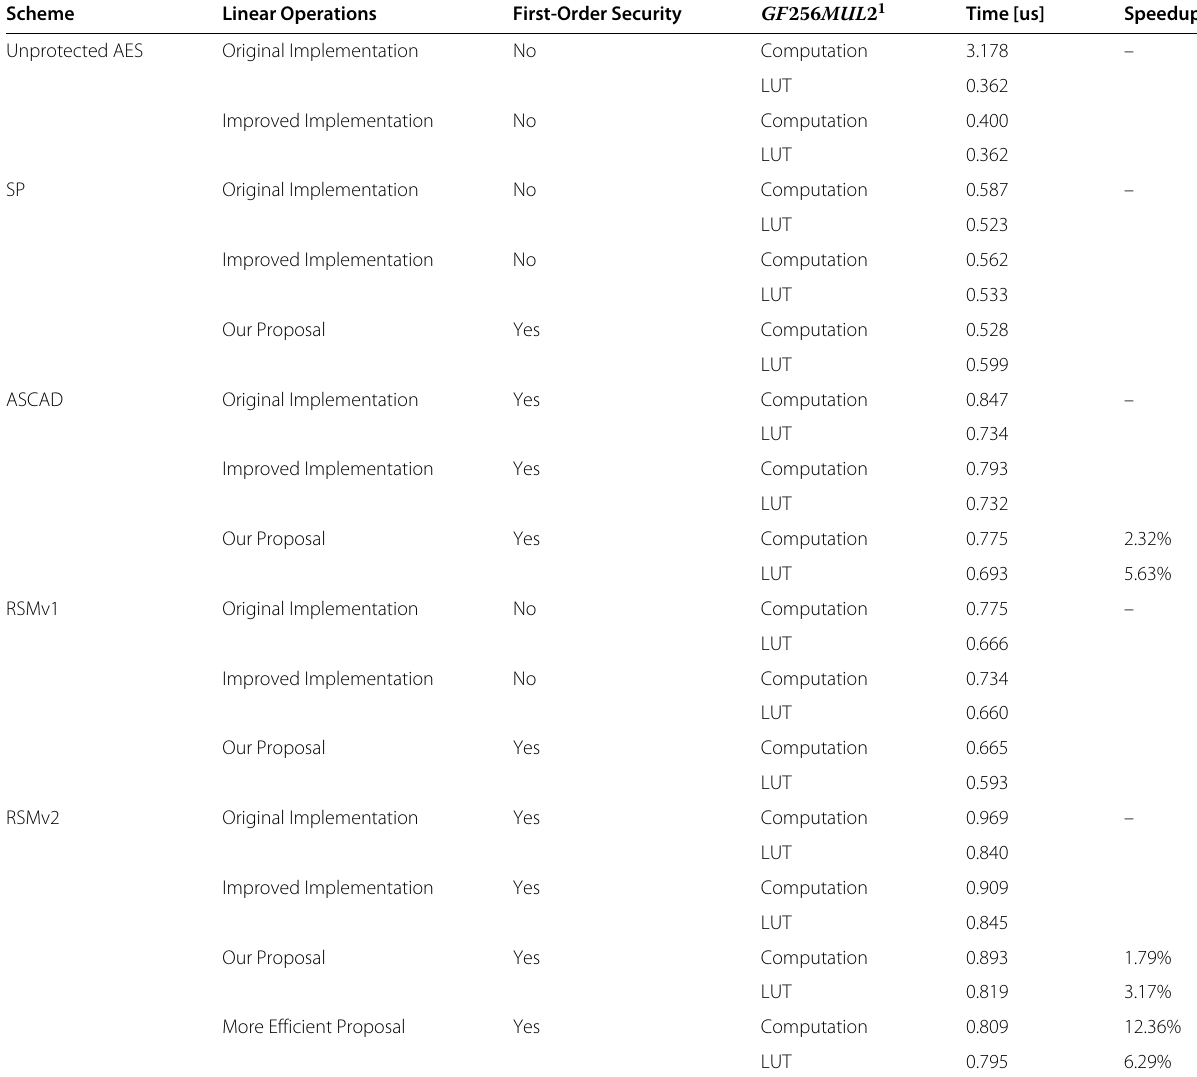
Table 7 Speedup in popular first-order masking schemes on an Intel Core i7-4790 CPU with “-O3” compiler option running at 3.60GHz